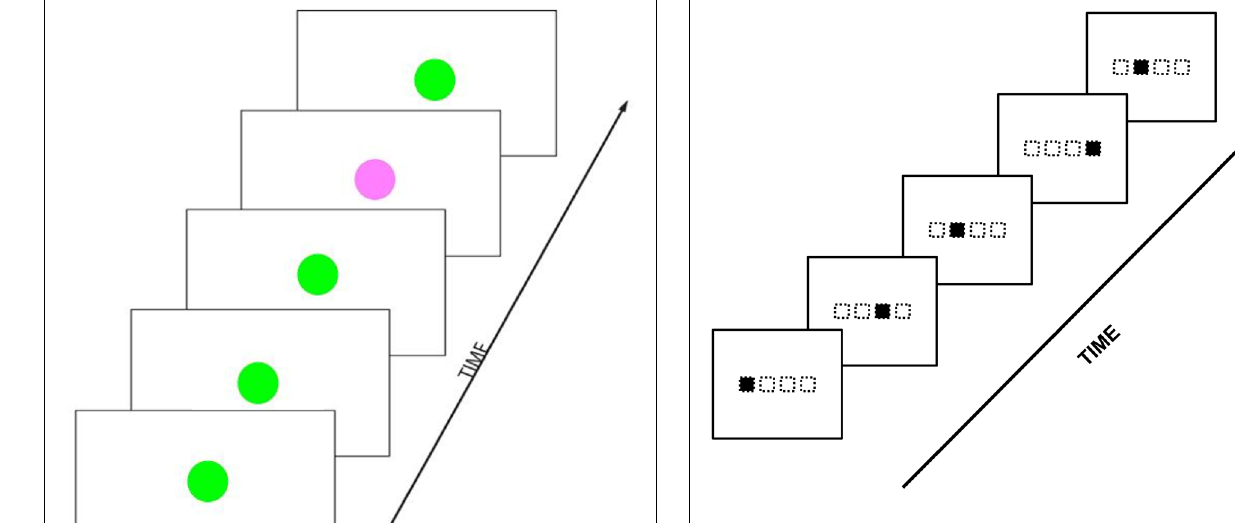
FIGURE 5 | One possible depiction of the serial reaction time task (Nissen and Bullemer, 1987). Visual stimuli appear at different – non-random – locations in a temporal sequence. Participants have to reproduce the displayed sequence by pressing on the touch screen at the correct locations and in the same temporal order as the displayed sequence. Note that the actual configuration of the stimulus locations can vary across